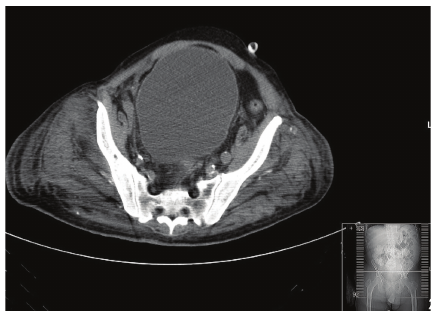
Figure 1: Patient 2: CT showing a grossly distended bladder blocking detailed visualization of the urethral catheter’s location.